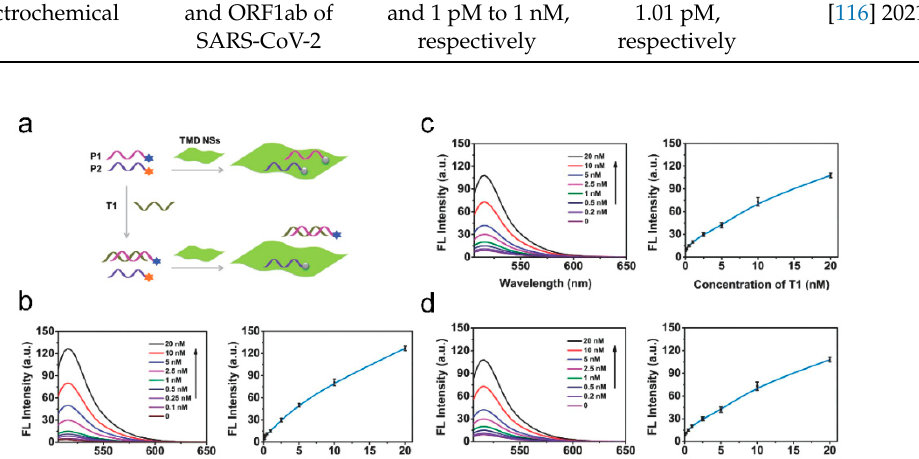
Figure 7. Multiplexed detection of H5N1 subtypes (T1 and T2) DNA by single-layer TMD nanosheets via FRET mechanism. ( a ) Schematic illustration of the sensing mechanism by multiplexed fluorescent DNA detection. Fluorescent spectra and intensity of ( b ) MoS 2 , ( c ) TiS 2 , and ( d ) TaS 2 , respectively. Figures are re-arranged and reprinted with permission from Ref. [106]. Copyright Wiley-VCH. (2014).